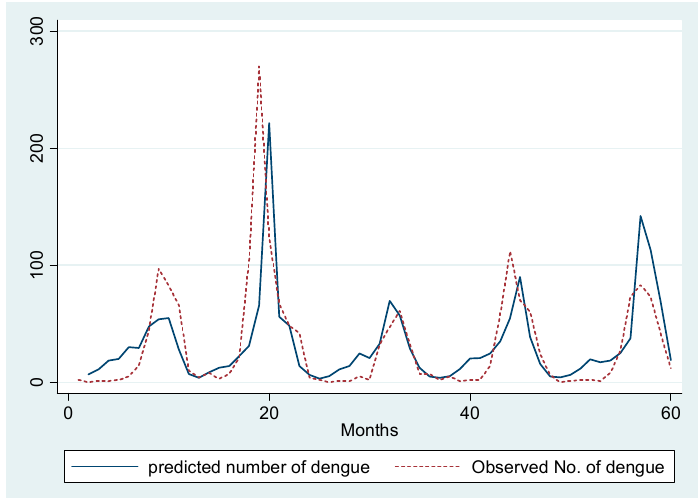
Table 1. ARIMA models and parameters estimates for each of the variables under study.